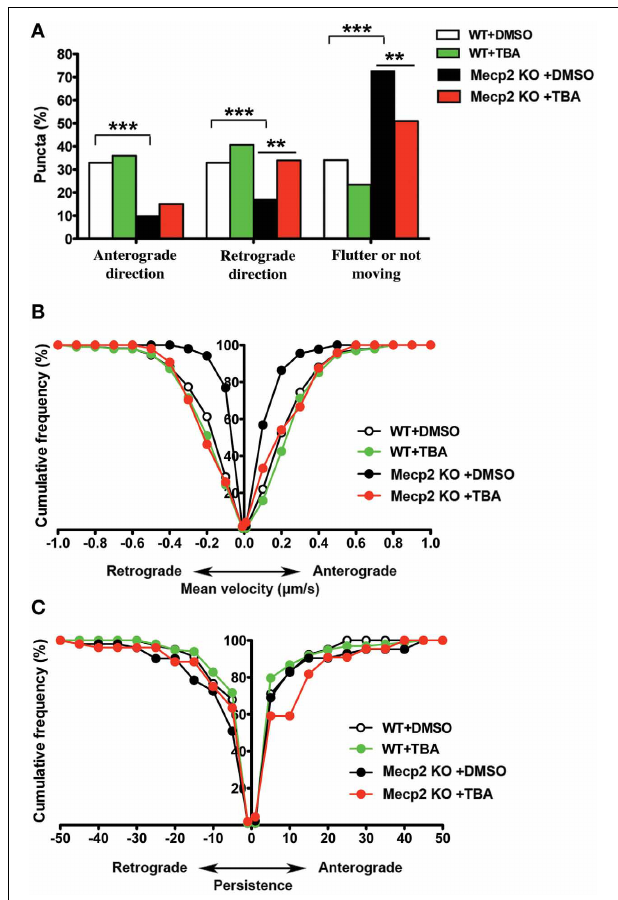
FIGURE 3 | TBA improves BDNF-YFP trafficking in Mecp2 knockout neurons. (A) Proportion of BDNF-YFP puncta that moves in anterograde or retrograde directions, flutter or not move in wildtype and Mecp2 knockout neurons, with or without TBA. (B) TBA increased the average velocity of both anterograde and retrograde BDNF-YFP puncta only in Mecp2 knockout neurons. (C) TBA did not affect BDNF puncta persistence in neither wildtype nor Mecp2 knockout neurons. ∗∗ p < 0 . 01; ∗∗∗ p < 0 . 001 wildtype vs. Mecp2